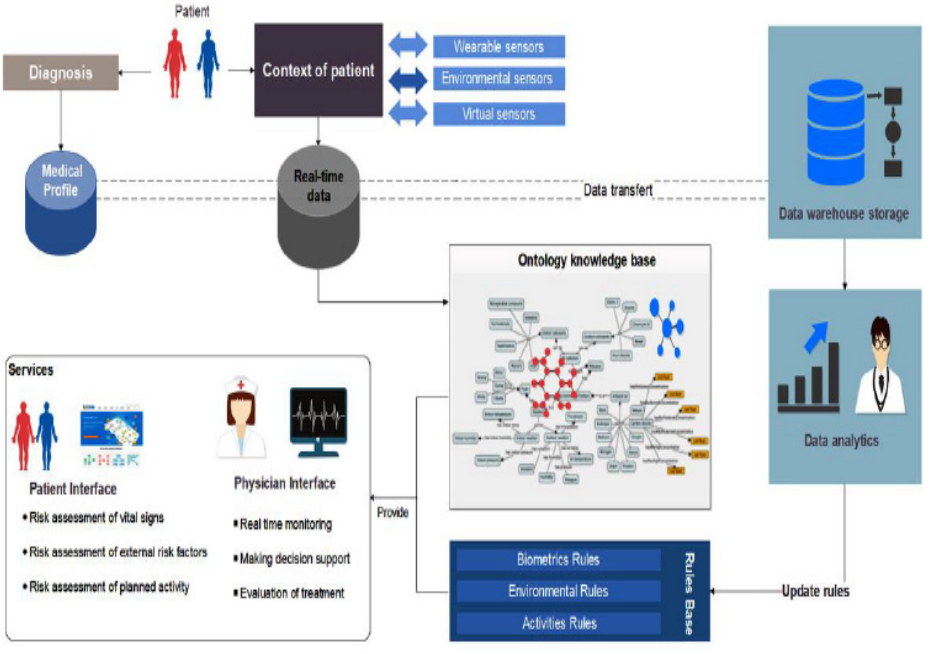
Figure 2. General architecture for ubiquitous COPD healthcare systems [13].